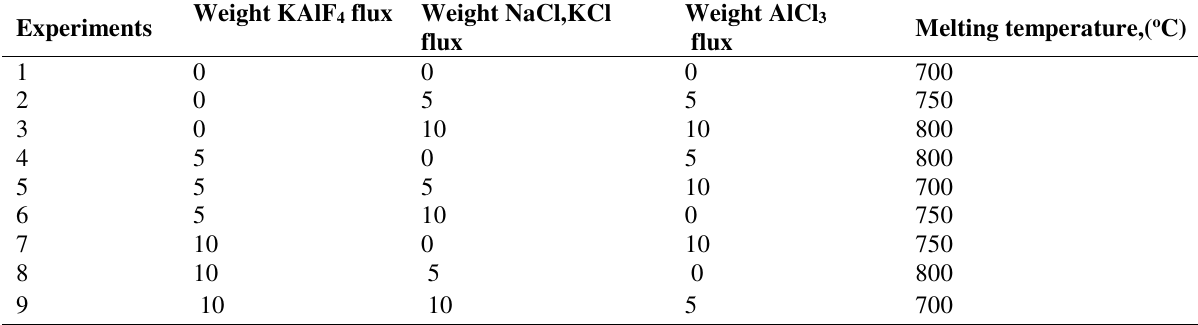
The experiments used in the melting